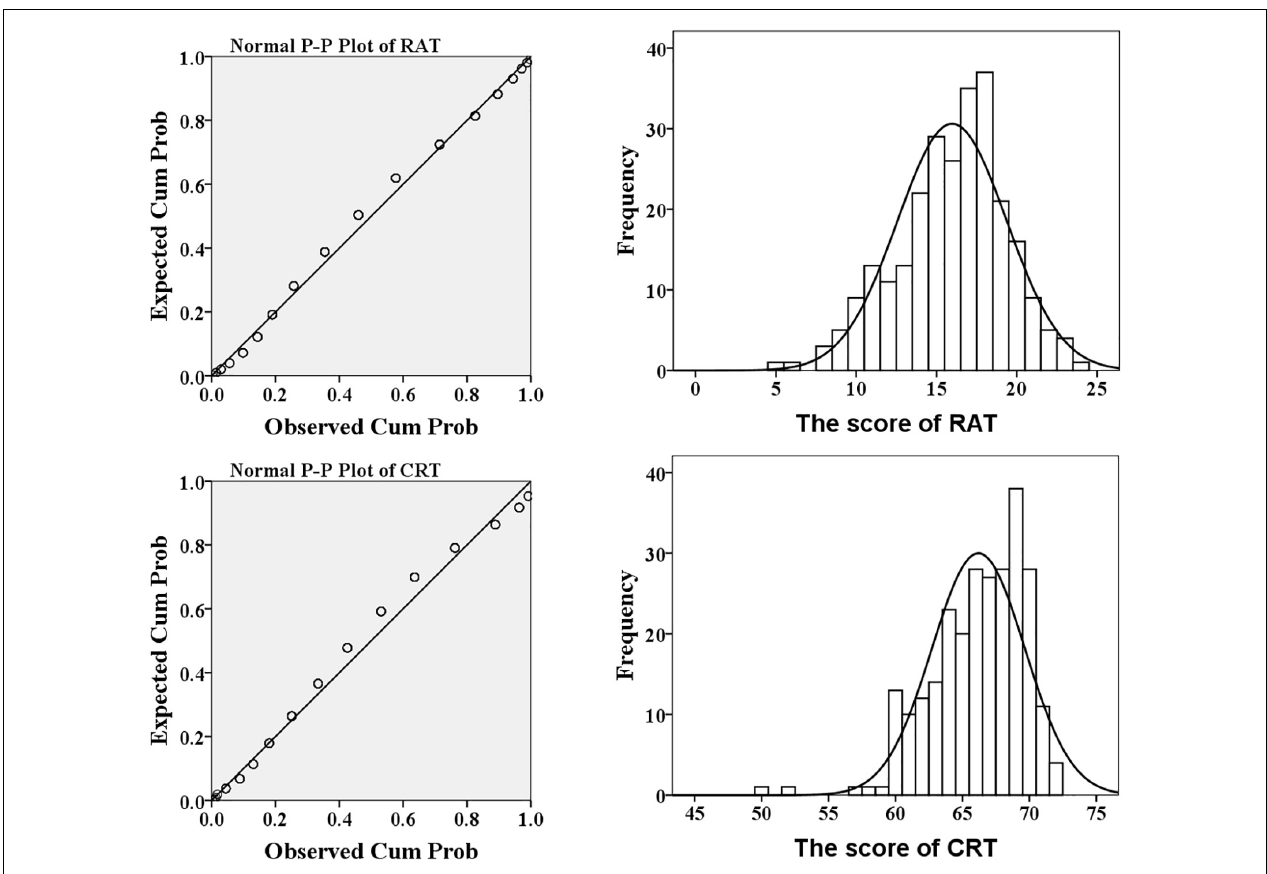
FIGURE 1 | The P-P plot and histogram of the score of RAT (upper) and CRT (lower).